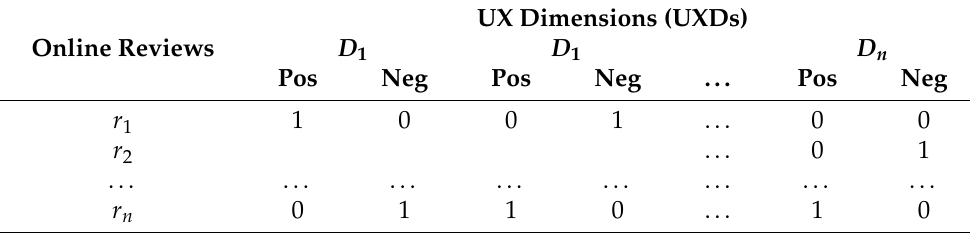
Table 2. Sentiment orientation toward each